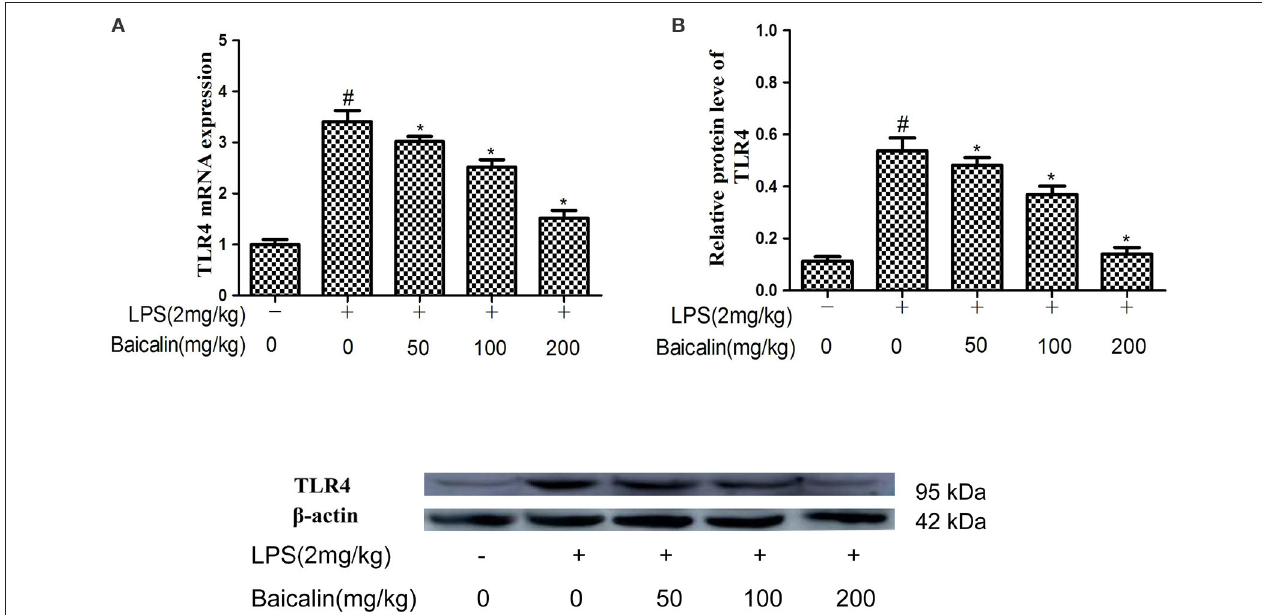
FIGURE 5 | Effects of Baicalin on TLR4 expression. TLR4 mRNA levels (A) , TLR4 protein levels (B) . Data are expressed as the mean ± SD ( n = 10). * P < 0.05vs. LPS group; # P < 0.05vs. control